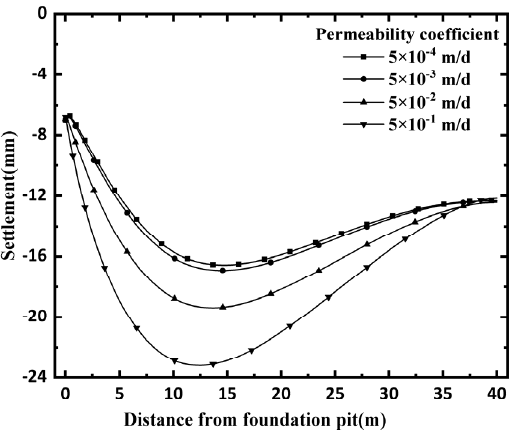
Figure 9. Horizontal displacement of different permeability coefficients with waterproof curtain.